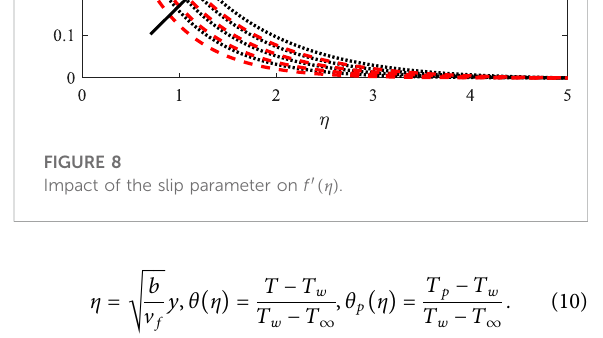
FIGURE 10 Impact of Prandtl number on θ ( η )